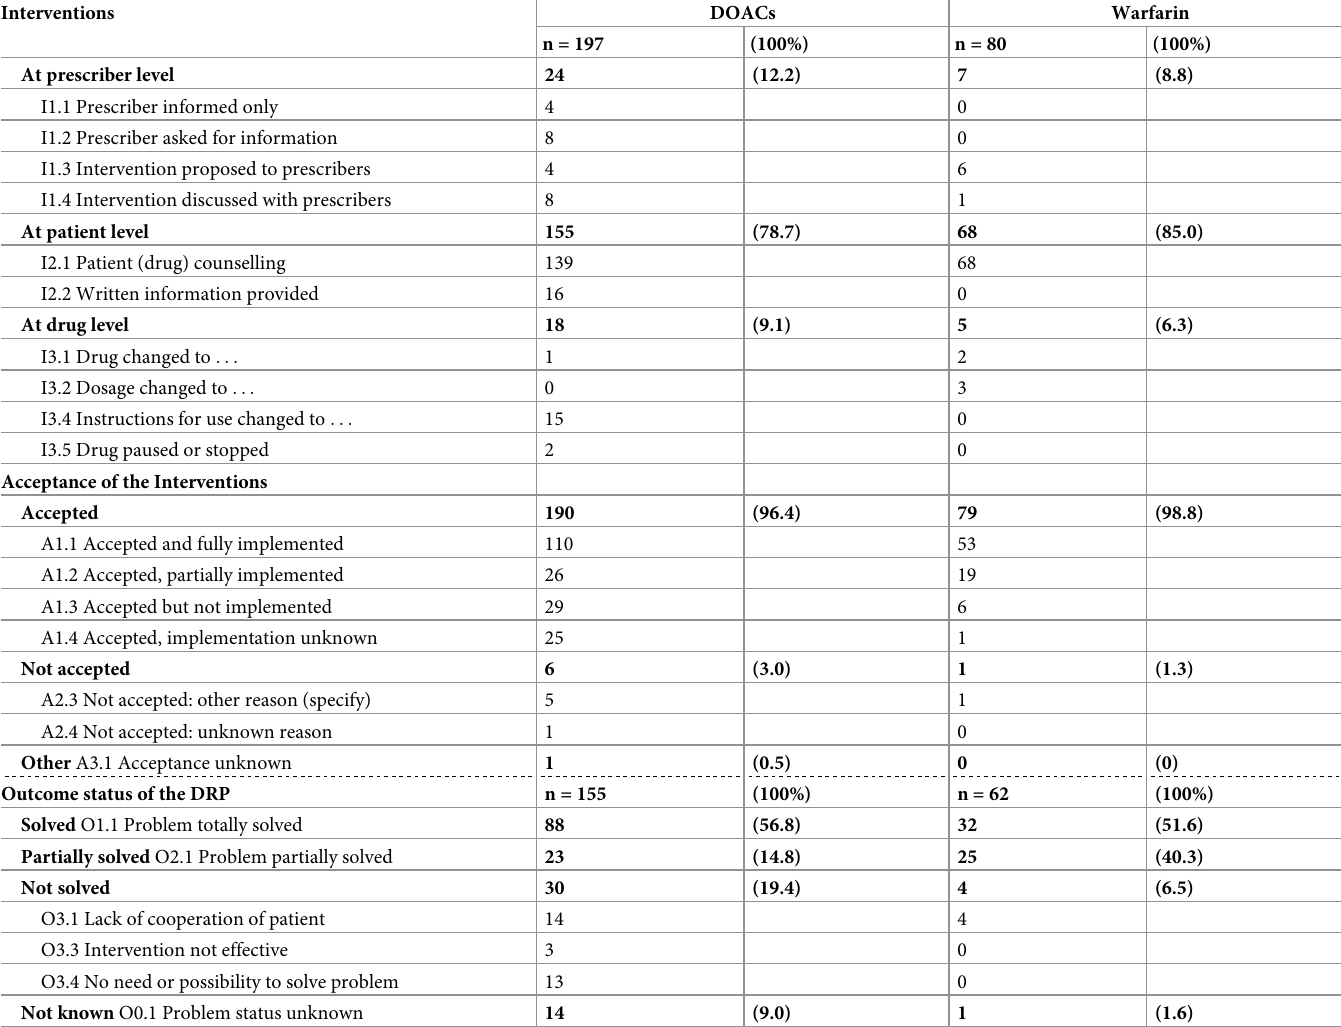
Table 2. Interventions, acceptance, and outcome status of the identified DRPs.